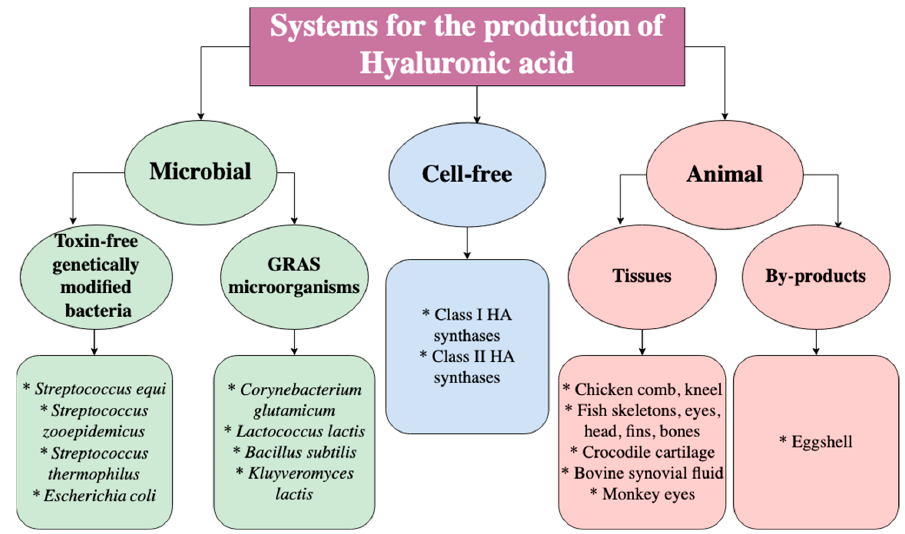
Figure 2. Different systems for the production of HA